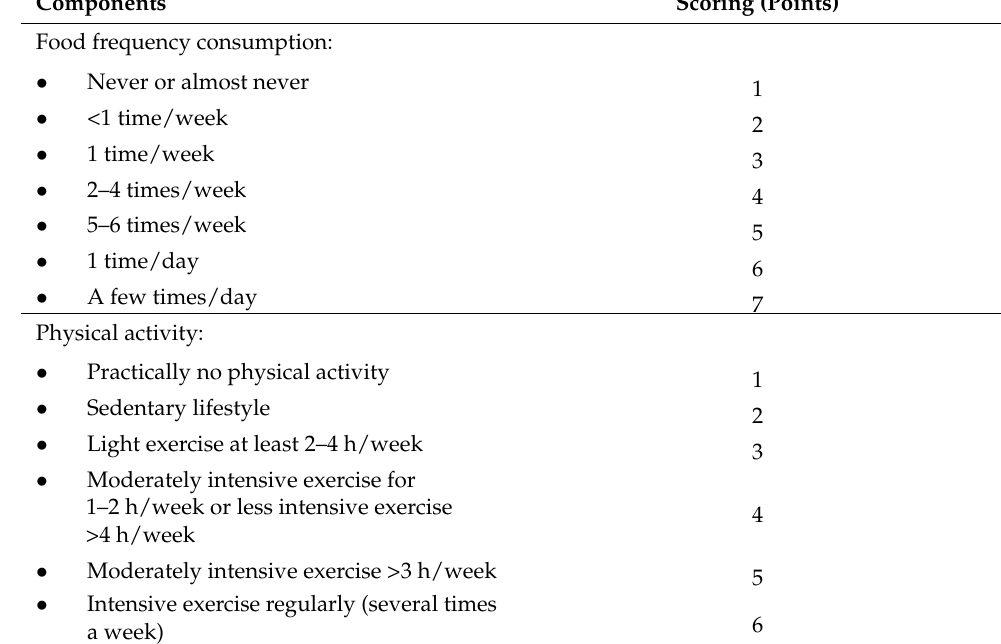
Table 1. Dietary–physical activity patterns (D-PAPs)—component data and scoring. Components Food frequency